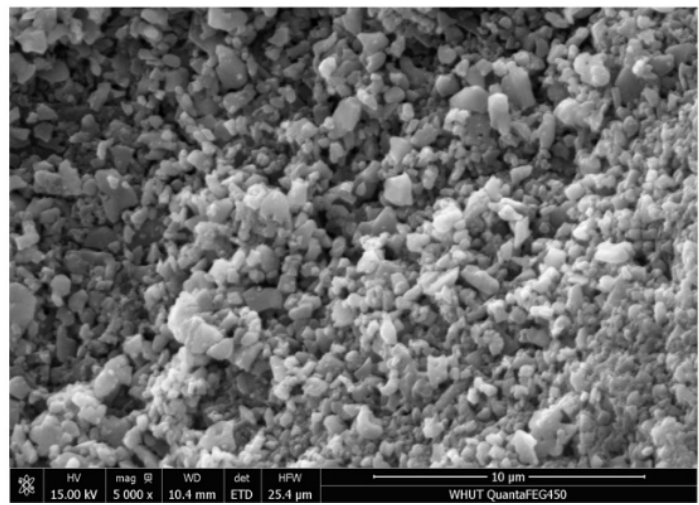
Figure 7. SEM (SE mode) Surface microstructure of the untreated sample.